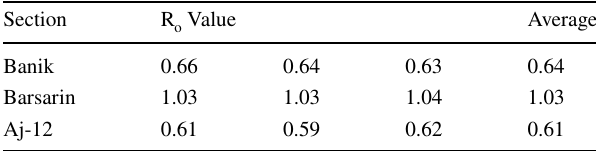
Table 6 The values of vitrinite reflectance of the Chia Gara Forma- tion